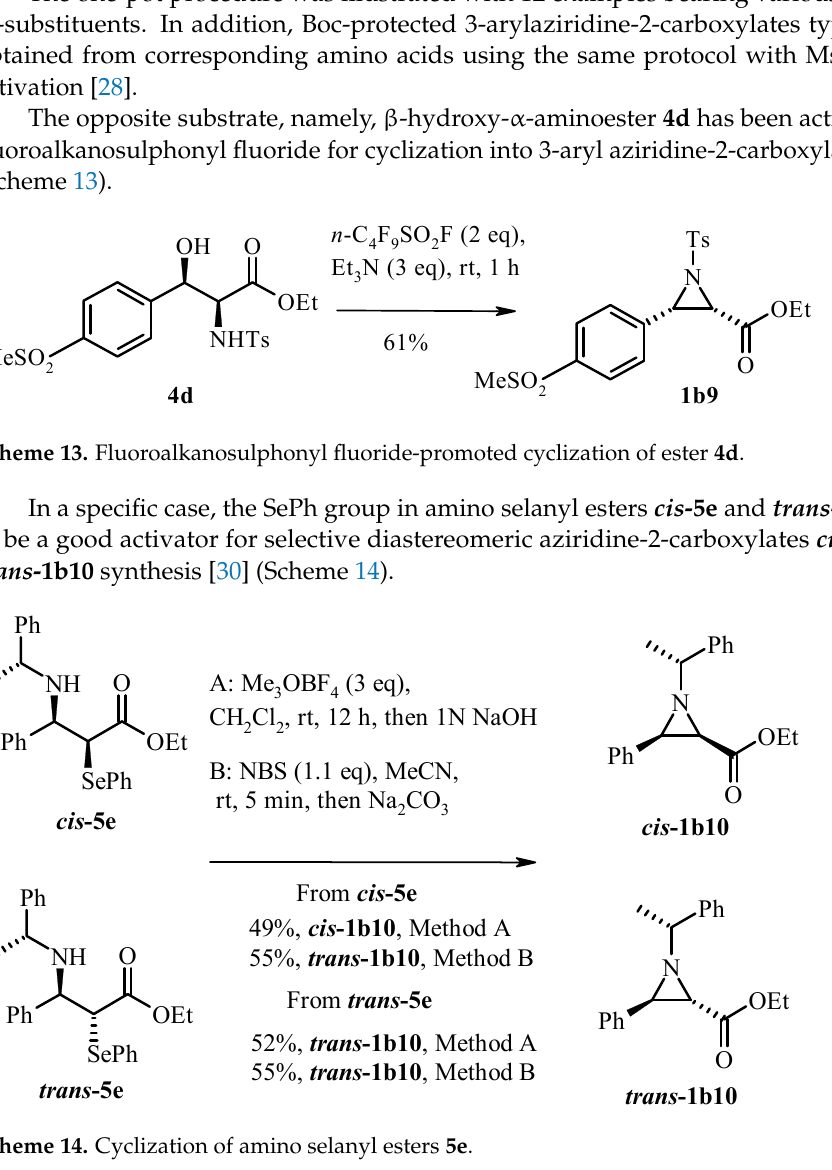
Scheme 14. Cyclization of amino selanyl esters 5e .